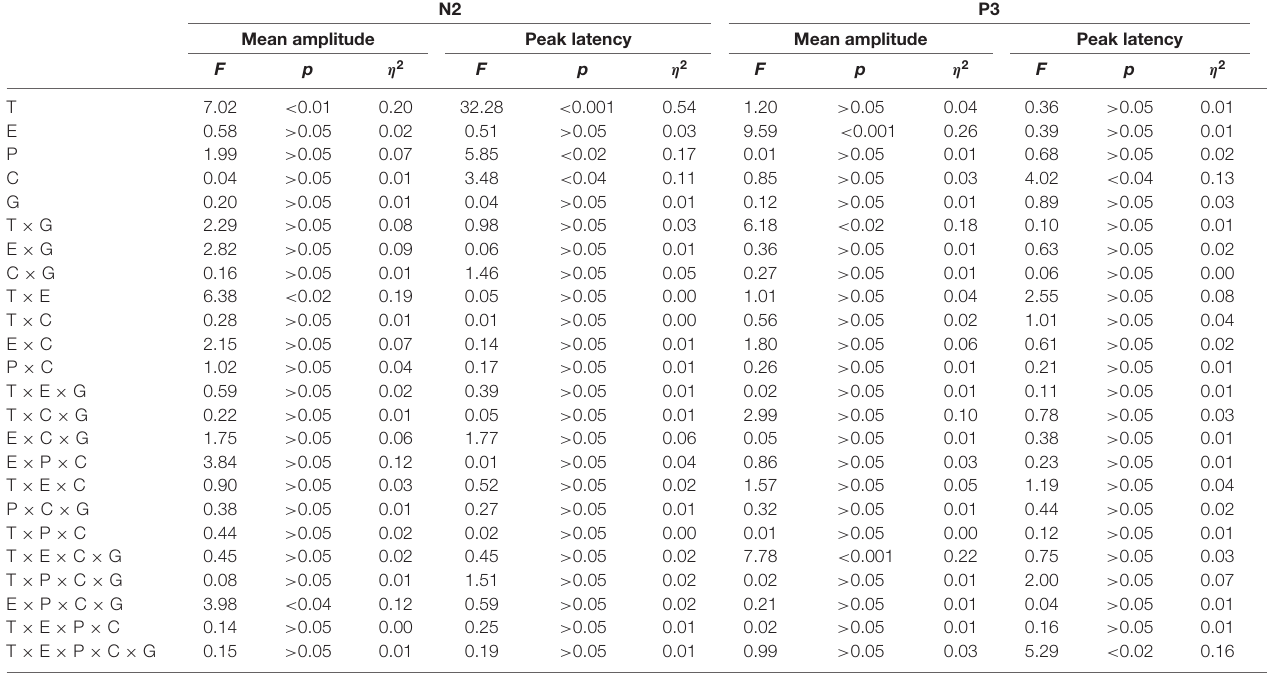
TABLE 4 | Results of the ANOVAs of the N2 and P3 mean amplitudes and latencies in 5-year-old